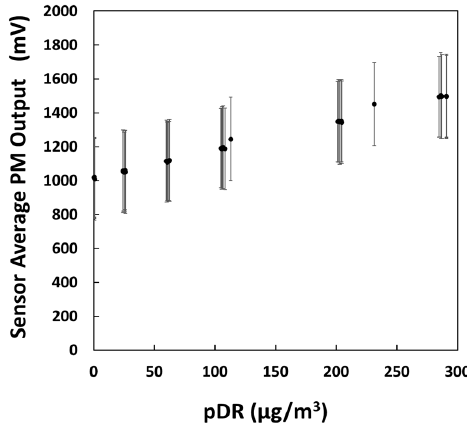
Figure 5. Sharp DN mV outputs for each monitor ( n = 30) relative to the particulate mass reported by the reference aerosol monitor for varying levels of salt